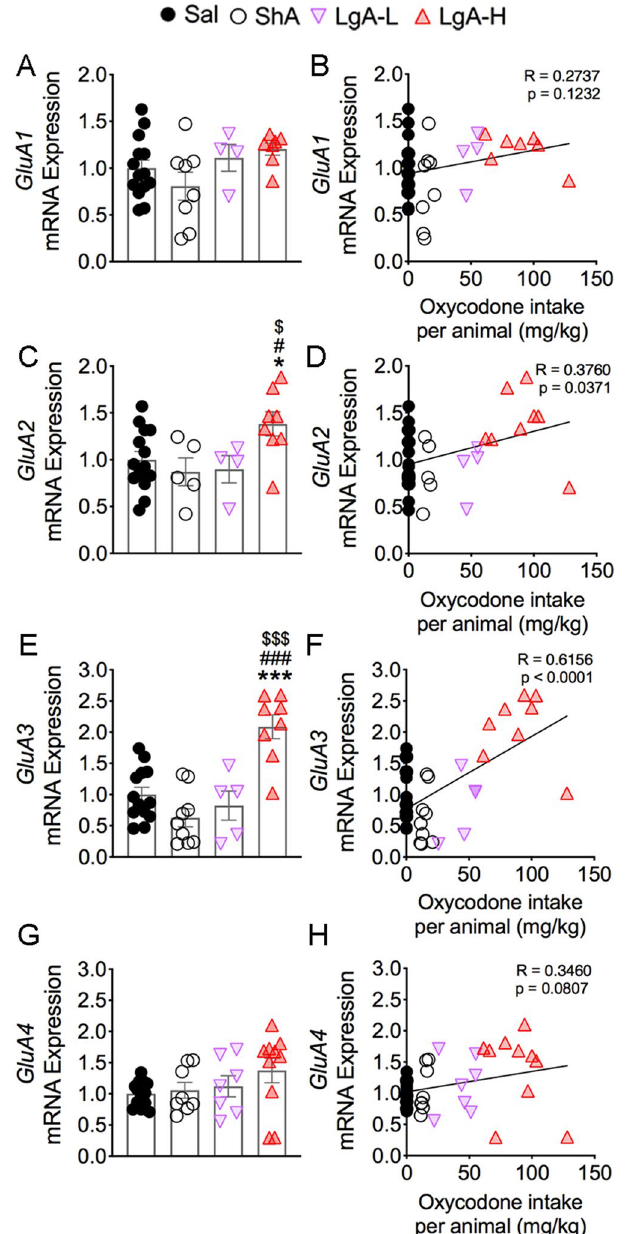
Figure 7. Consequences of oxycodone SA and early withdrawal on mRNA on GluA1 , GluA2 , GluA3 , and GluA4 mRNA levels. mRNA levels of ( A ) GluA1 and ( G ) GluA4 were not significantly affected. There were no correlations between ( B ) GluA1 and ( H ) GluA4 mRNA levels and the consumption of oxycodone. However, ( C ) GluA2 and ( E ) GluA3 mRNA levels were significantly increased in the LgA-H rats, with significant positive correlations between mRNA expression of ( D ) GluA2 and ( F ) GluA3 with the amount of oxycodone taken. Key to statistics: *, *** = p < 0.05, 0.001, respectively, in comparison to Sal rats; #, ### = p < 0.05, 0.001, respectively, in comparison to SHA rats; $, $$$ = p < 0.05, 0.001 in comparison to LgA-L rats (n = 10–11 Sal; n = 5–9 ShA; n = 4–7 LgA-L; n = 7–10 LgA-H). Statistical analyses are as described in Fig.